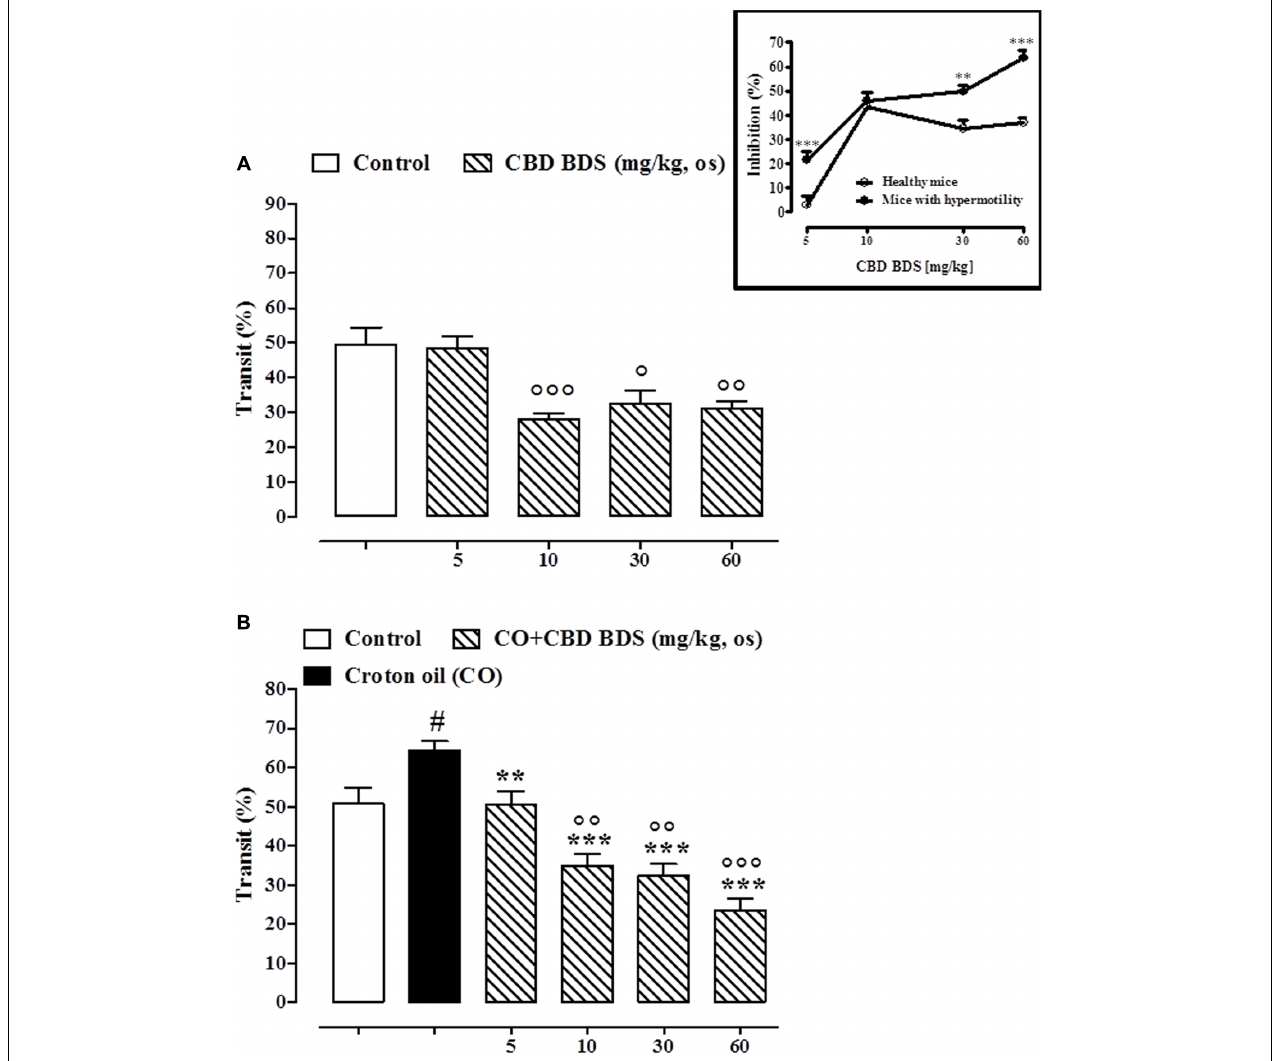
FIGURE 5 | Effect of CBD BDS (10–60 mg/kg, by oral gavage) on intestinal transit in healthy mice (A) and croton oil-treated mice (B). Bars represent the mean ± SEM of 8–10 animals for each experimental group. ◦ and # p < 0.05, ◦◦ p < 0.01 and ◦◦◦ p < 0.001 vs. control and ∗∗ p < 0.01 and ∗∗∗ p < 0.001 vs. croton oil alone. Insert: Difference between the curves representing the inhibitory effect of CBD BDS on intestinal transit in healthy mice and mice with hypermotility (mice treated with croton oil). Results are expressed as mean ± SEM of 8–10 mice for each experimental group. ∗∗∗ p < 0.001 vs. healthy